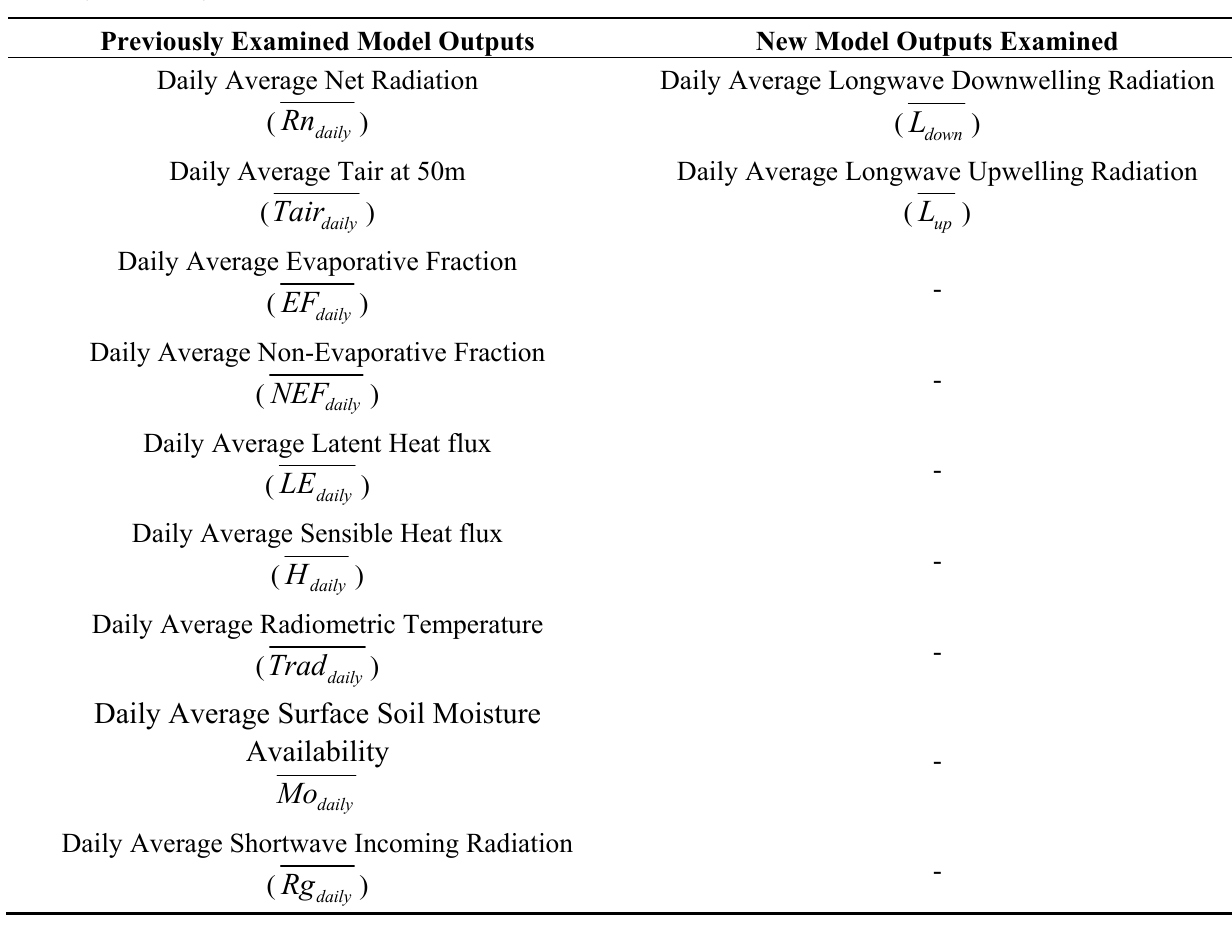
Table 1. Summary of the previously and newly examined SimSphere outputs considered in the Global Sensitivity Analysis (GSA) implementation using the Bayesian analysis of computer code outputs (BACCO) Gaussian emulation machine for sensitivity analysis (GEM-SA)